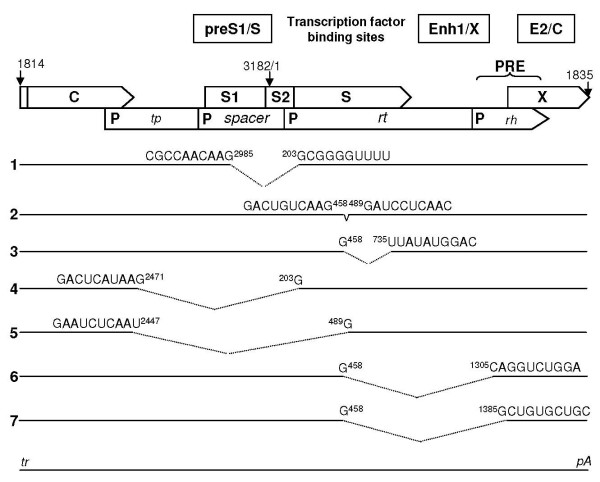
RNA splicing possibilities in the HBV genome. Splice patterns in HBV pregenomic RNA are predicted by NetGene2. Genome organization is presented as functional domains in pgRNA decorated with transcription factor binding sites (upper two panels) from terminal repeat (tr) to polyadenylation sequence (pA) (bottom line). PRE indicates the position of the Posttranscriptional Regulatory Element. Different modes of splicing are numbered and referred to in the text.